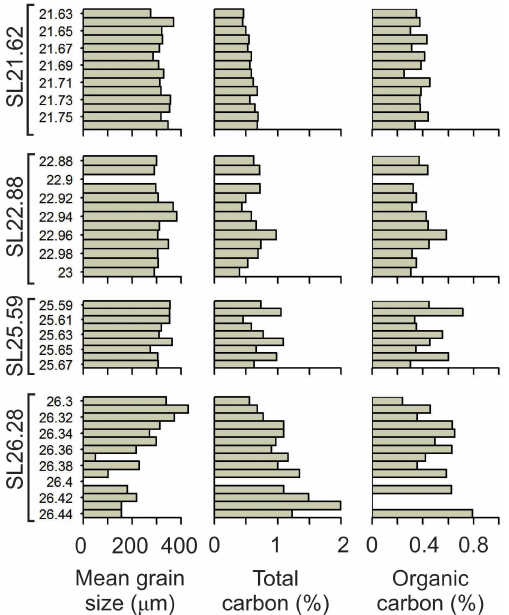
Figure 5. Mean grain size (µm), percentage of total carbon (%), and percentage of organic carbon (%) in sediment sections removed from the 27m ice core from Lake Vida. dates vary significantly, especially in the upper ice where there is no correlation between age and depth. The dates from SL26.28 do show increasing age with depth (4909 ± 46 to 6300 ± 49 14 C yr BP). It is noted that δ 13 C values are unreli- able and not reported due to high fractionation during accel- erator mass spectrometry measurements. OSL samples showed no evidence of exposure to sun- light during collection and returned dates of 320 ± 40 and 1200 ± 100 yr BP for SL21.62 and SL25.59, respectively, dates which are younger than the radiocarbon ages from the respective